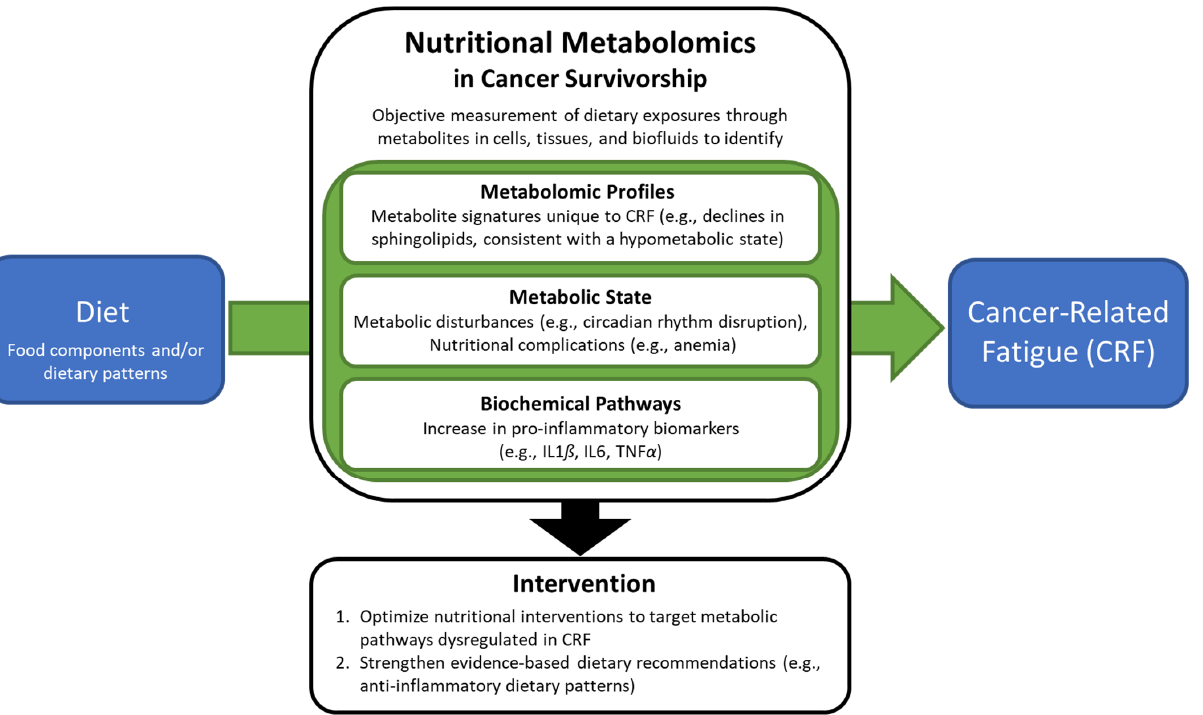
Figure 1. Nutritional Metabolomics in Cancer Survivorship.